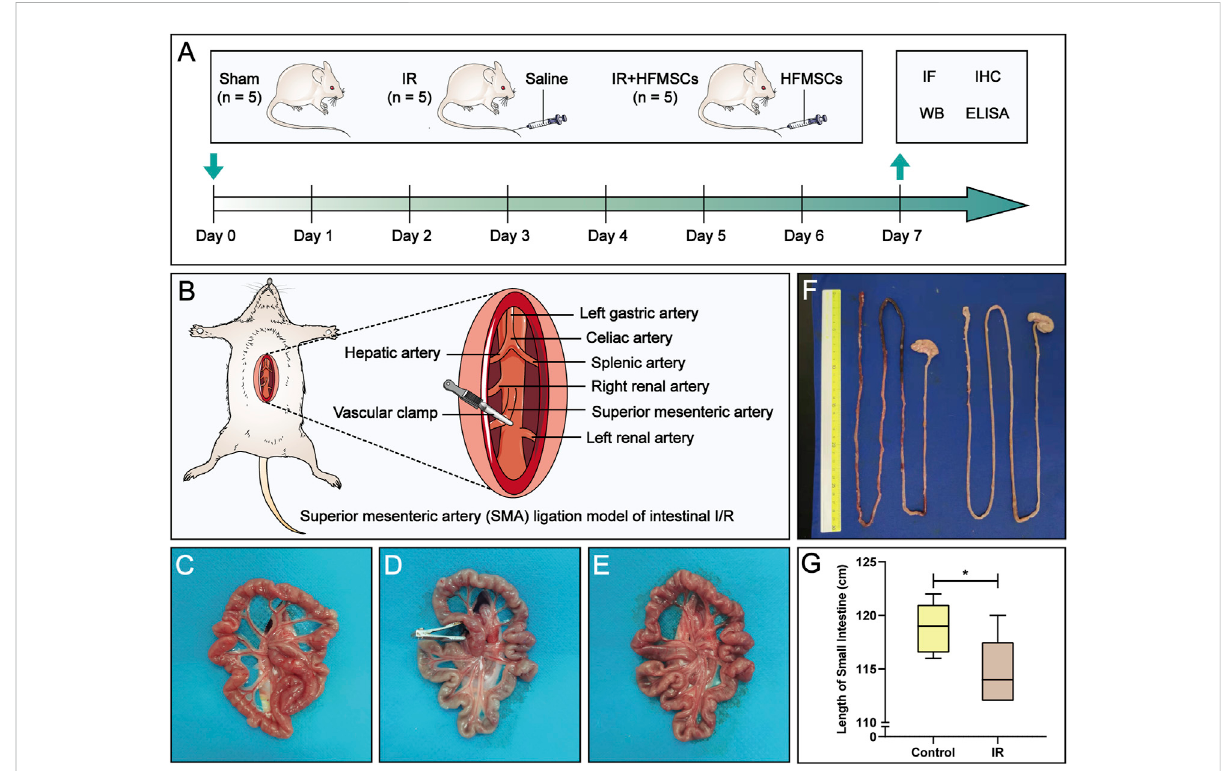
FIGURE 1 Experimental design and macroscopic evaluation of a small intestinal IR injury model. (A) The experimental animals were divided into three groups: the sham group ( n = 5), IR group ( n = 5) and IR + HFMSCs group ( n = 5). Immuno fl uorescence analysis, immunohistochemistry, Western blotting,andELISAwereperformedonday7toevaluatethetherapeuticeffectofHFMSCs. (B) Thesuperiormesentericartery(SMA)wasclampedand opened to establish anintestinalIRinjury model. (C – E) The morphologyofthesmallintestine before (C) ,during (D) , andafter (E) SMAclamping is shown. (F) Small intestinal length was compared between the control group ( n = 5) and the IR group ( n = 5). (G) A statistical comparison of small intestinal length was performed. Data are presented as the mean ± SD (* p <